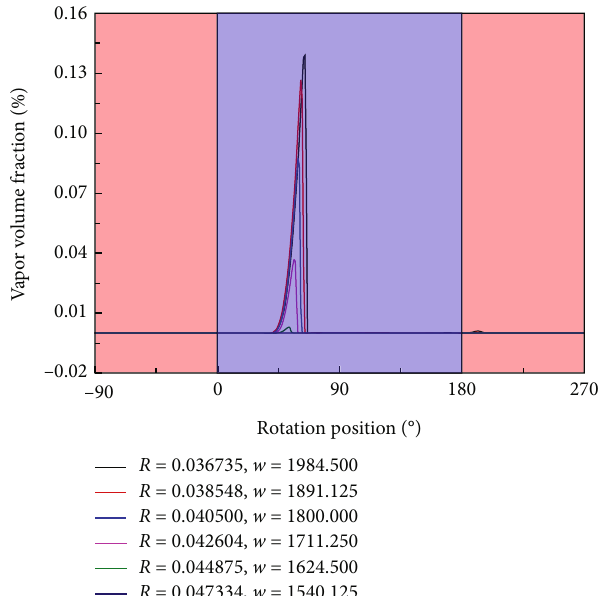
Figure 14: The vapor volume fraction curves in the plunger chamber with di ff erent distribution circle radii and rotation speeds.